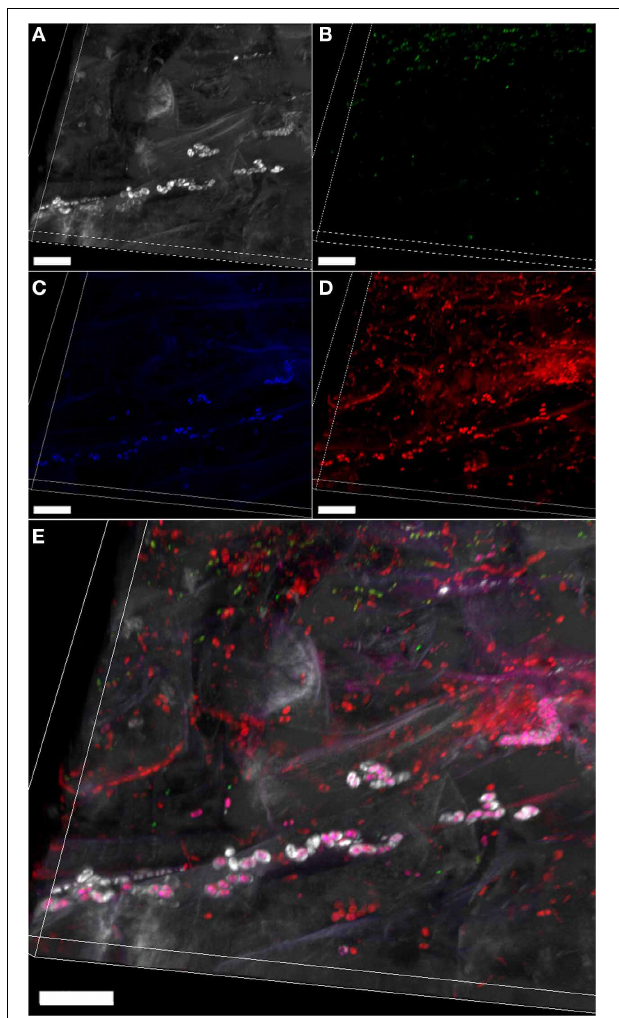
FIGURE 2 | Combination of FISH with histochemical staining. Volume rendering of a confocal stack showing the bacterial colonization of salad root ( Lactuca sativa ) by the native bacterial community, stained by FISH. Gammaproteobacterial (A) , betaproteobacterial (B) , and other bacterial cells (C) (green, blue, and red, respectively) stained with the FISH probes Gam42a (Cy5-labeled), Bet42a (ATTO488-labeled) and EUBMIX (Cy3-labeled), respectively. (D) Compounds and tissues stained with calcofluor white (0.15% in H 2 O, 15min incubation) appear gray. (E) Overlap of images (A–D) ; yellow, Gammaproteobacteria; pink, Betaproteobacteria; red: other bacteria; gray: compounds surrounding some Betaproteobacteria stained by calcofluor white. Scale bars: 20 μ m. Confocal stack has a thickness of 16.99 μ m, and was acquired with a Leica TCS SPE (Leica